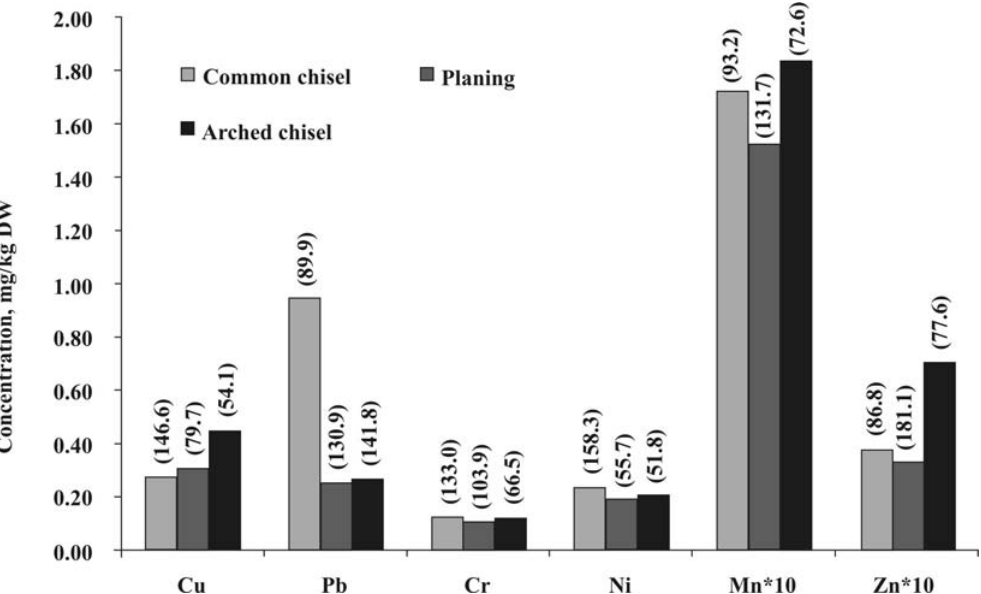
Fig 7. Median data of metal concentrations in wood (mg/kg dry weight) and the percentage coefficient of variation (in parenthesis) of the elemental data for each tree-sampling technique (n = 8) Table. Kruskal–Wallis H –test analyses with p–values (in parenthesis) from the sample populations of the three sampling techniques for each elemental parameter (n = 8) TM H–value TM H–value Cu 1.22 (0.544) Ni 0.65 (0.724) Pb 2.90 (0.235) Mn 1.37 (0.505) Cr 0.59 (0.743) Zn 4.45